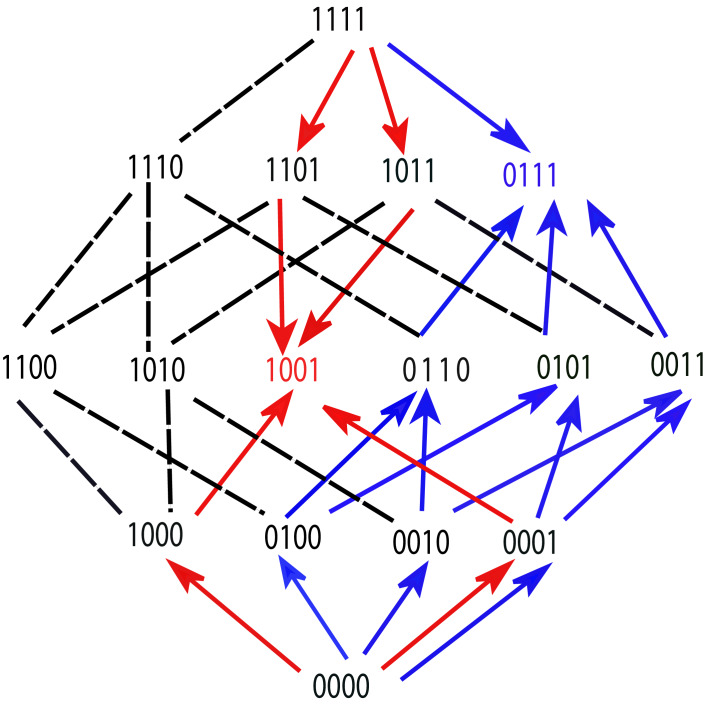
A fitness graph of a landscape with L=4 mutations, illustrating the accessibility property.There are two fitness peaks, 1001 (red) and 0111 (blue). The fitness peaks are accessible from all their subset and superset genotypes following the paths marked by the arrows.